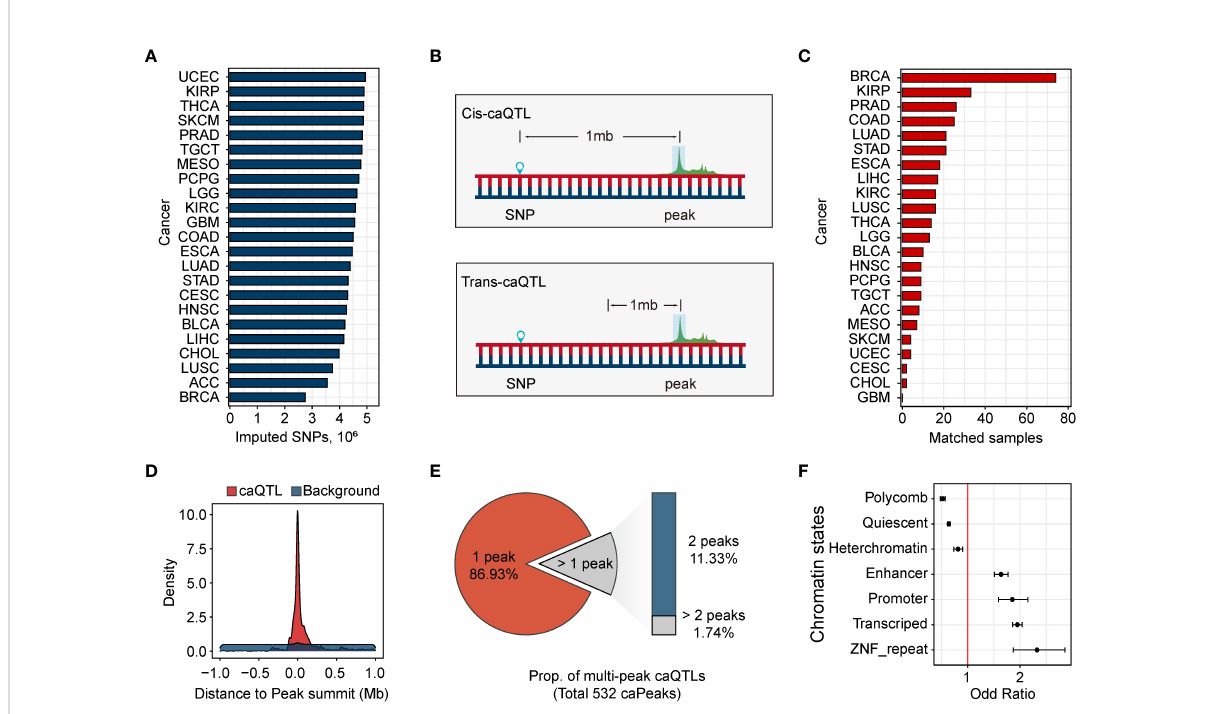
FIGURE 2 Genetic variants associated with chromatin accessibility. (A) Distribution of the number of the ATAC-peaks in 23 human cancers. (B) Cis-caQTLs are identi fi ed using the variants within 1 Mb of ATAC-peaks, and caQTLs outside the window are de fi ned as trans-caQTLs. (C) The number of samples with matched ATAC-seq data and SNP genotype data. There is no matched sample in GBM. (D) Distribution of the distance between caQTL SNPs and their related caQTL peaks. Distance distribution between caQTL SNPs and caQTL peak, red. Distance distribution between all tested variants and their tested ATAC-peaks, blue. (E) Distribution of the number of single-peak caQTLs and multi-peak caQTLs. (F) Enrichment of caQTL SNPs in breast chromatin states. Error bars represent 95% con fi dence